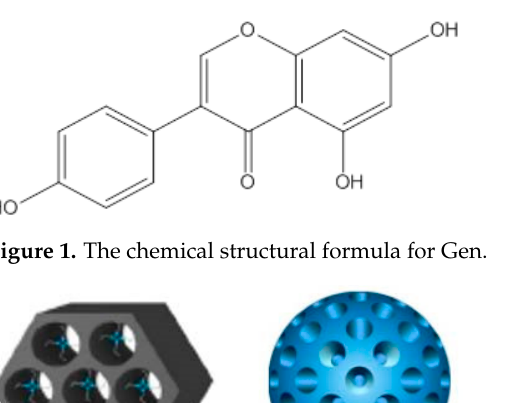
Figure 1. The chemical structural formula for Gen.